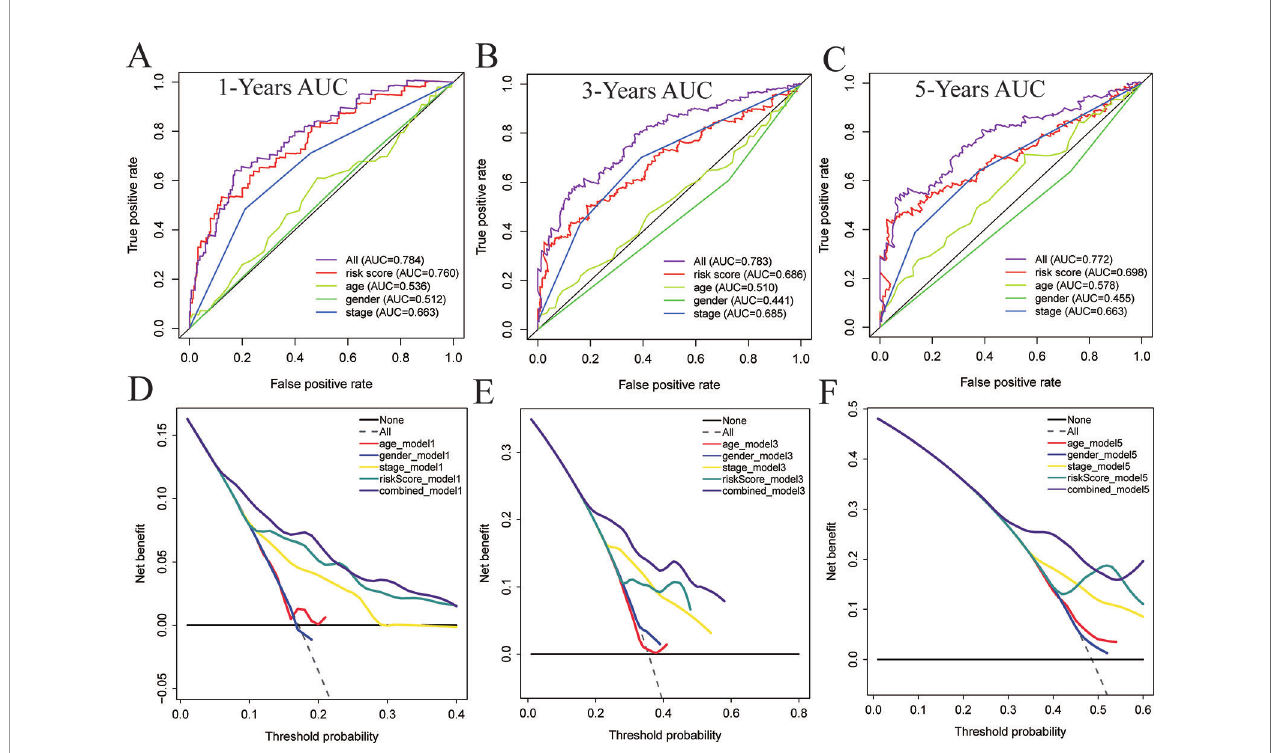
FIGURE 9 | The time-dependent receiver operating characteristic (ROC) and decision curve analysis (DCA) curves of the nomograms. Time-dependent ROC curve analysis evaluates the accuracy of the nomograms (A – C) . The purple , red , yellow , green , or blue solid line represents the nomogram. The DCA curves can intuitively evaluate the clinical bene fi t of the nomograms and the scope of application of the nomograms to obtain clinical bene fi ts (D – F) . The net bene fi ts ( Y -axis) as calculated are plotted against the threshold probabilities of patients having 1, 3-, and 5-year survival on the X -axis. The gray dotted line represents the assumption that all patients have 1-, 3-, and 5-year survival. The black solid line represents the assumption that no patients have 1-, 3-, or 5-year survival. The red , blue , yellow , green , or purple solid line represents the